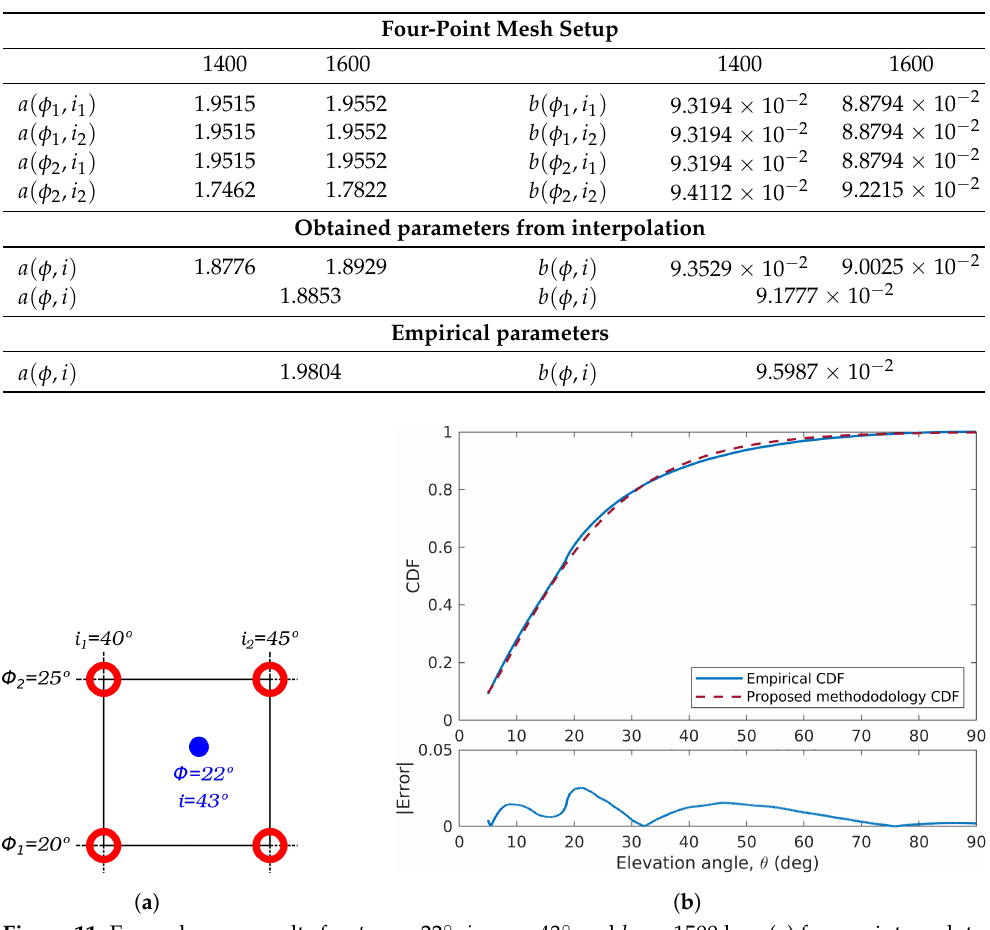
Table 9. Shape and scale parameters for the elevation angle PDF and CDF for φ ES = 22 ◦ and i SAT = 43 ◦ at h k = 1500 km, corresponding to the four-point mesh shown in Figure 11a. Four-Point Mesh Setup